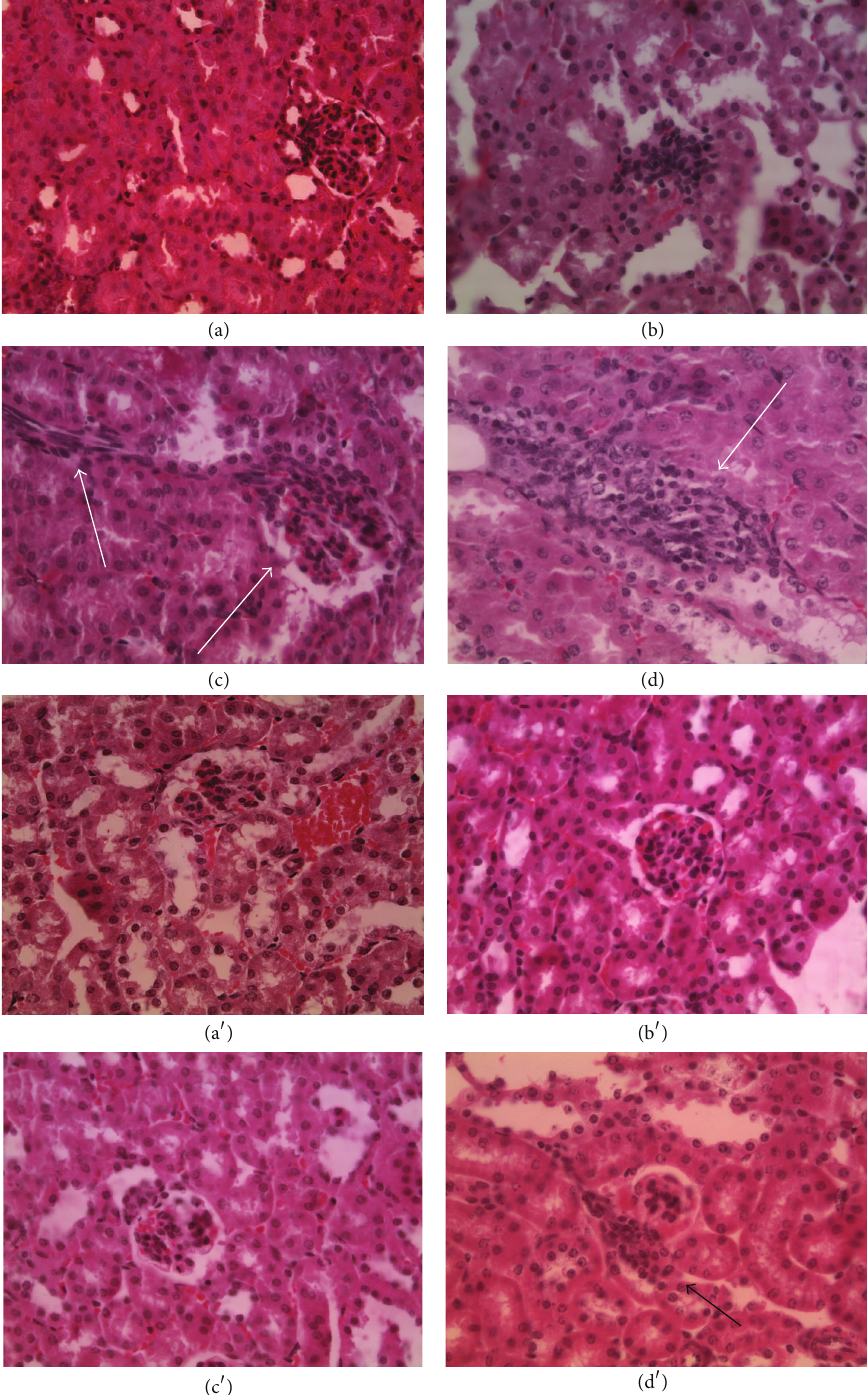
Figure 6: Kidney sections. ((a) and (a 󸀠 )) Control, magnification 40x; ((b) and (b 󸀠 )) low concentration, magnification 40x; ((c) and (c 󸀠 )) medium concentration, magnification 40x; ((d) and (d 󸀠 )) high concentration, magnification 40x. (a), (b), (c), (d) males and (a 󸀠 ), (b 󸀠 ), (c 󸀠 ), (d 󸀠 ) females. Arrows indicate small lymphoid